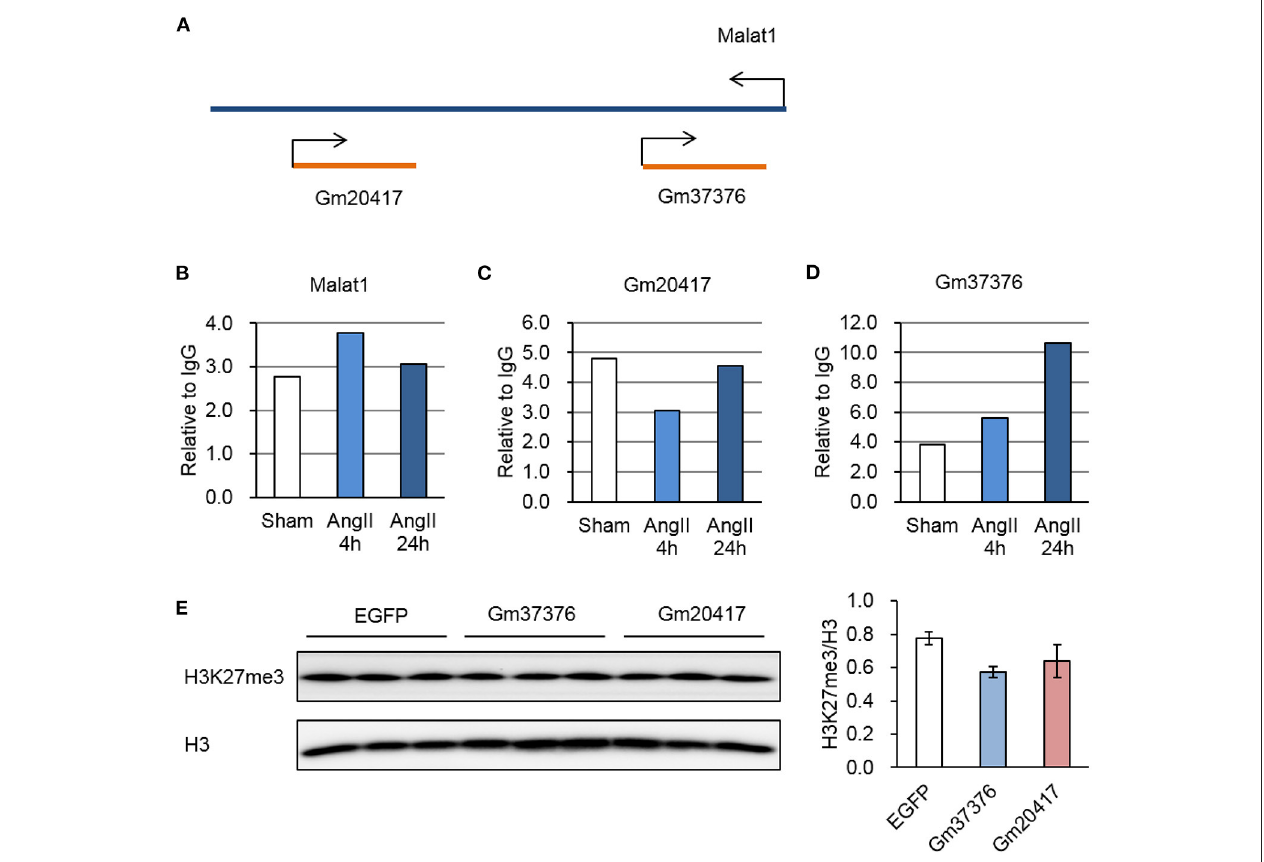
FIGURE 6 | Dynamic interaction between EZH2 and Malat1 locus-derived lncRNAs during AngII treatment. (A) Schematic diagram of the Malat1 genomic structure together with two antisense lncRNAs, Gm20417, and Gm37376. (B–D) Relative reads of Malat1 (B) , Gm20417 (C) and Gm37376 (D) normalized to corresponding IgG groups. (E) Impact of Gm37376 and Gm20417 on H3K27me3 in MEFs. Cells were collected 24h after transfection, and the lysates were immunoblotted with anti-H3K27me3 and anti-H3 antibodies. Data are mean ± SEM; n =